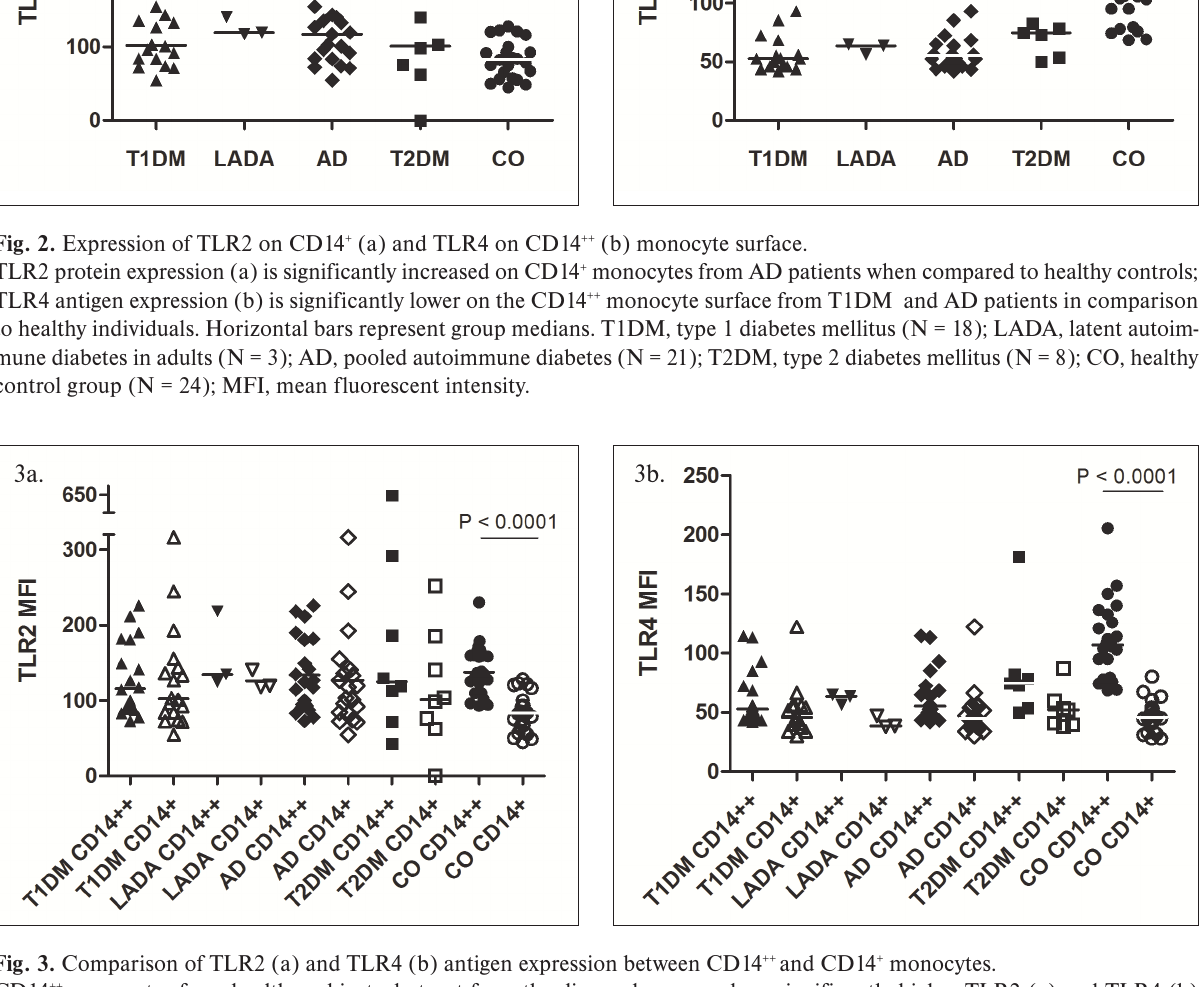
Fig. 3. Comparison of TLR2 (a) and TLR4 (b) antigen expression between CD14 ++ and CD14 + monocytes. CD14 ++ monocytes from healthy subjects, but not from the diseased groups, show significantly higher TLR2 (a) and TLR4 (b) expression than CD14 + monocytes. Horizontal bars represent group medians. T1DM, type 1 diabetes mellitus (N = 18); LADA, latent autoimmune diabetes in adults (N = 3); AD, pooled autoimmune diabetes (N = 21); T2DM, type 2 diabetes mellitus (N = 8); CO, healthy control group (N = 24); MFI, mean fluorescent intensity